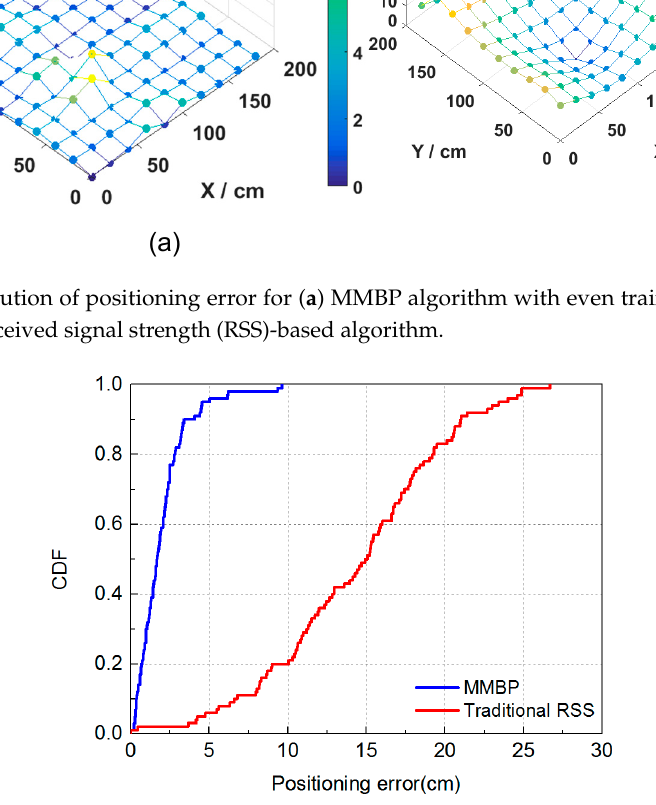
Figure 9. Cumulative distribution of positioning error for the MMBP algorithm using even training data set and traditional RSS-based algorithm.